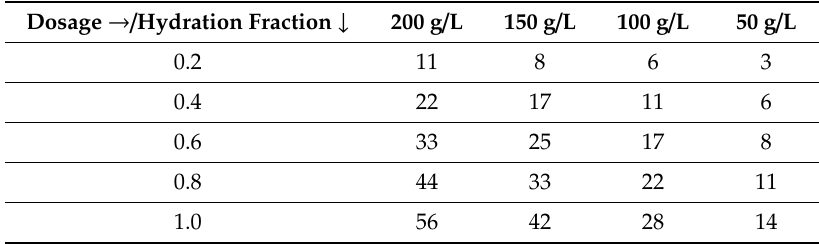
Table 1. Temperature increase ( ∆ T; ◦ C) in water as function of dosage of burnt lime and its hydration fraction as calculated from Equations (1) and